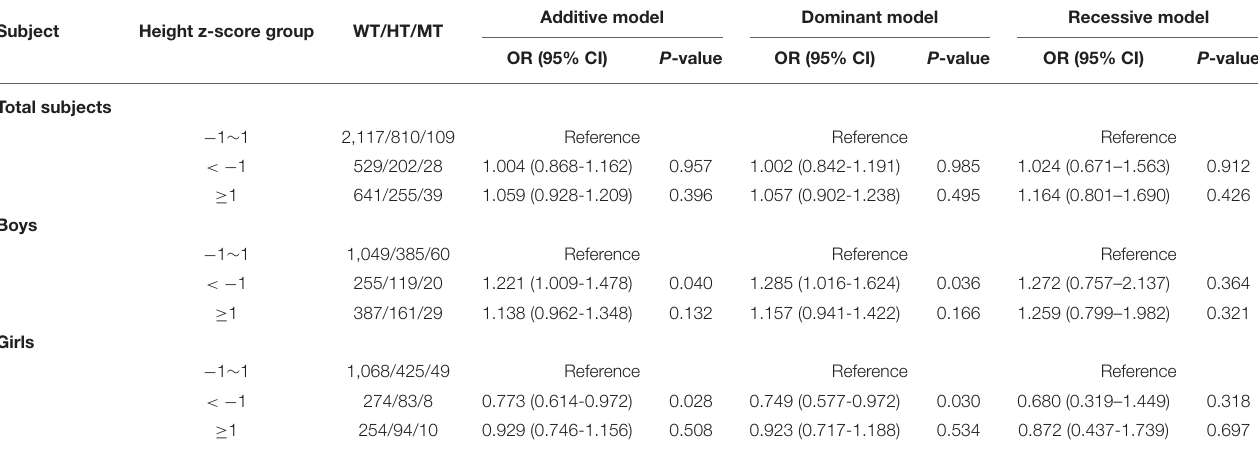
TABLE 2 | Association analysis of GHR fl/d3 polymorphism with